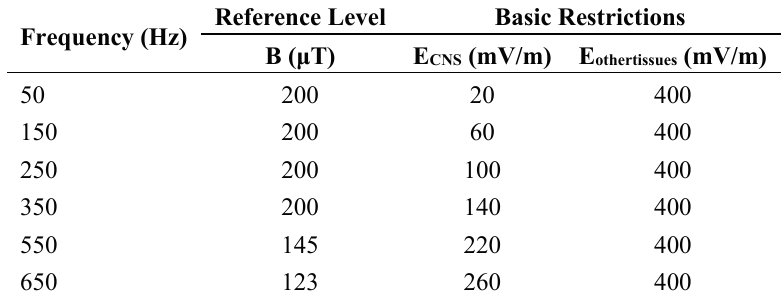
Table 2 as Reference Levels for magnetic flux density B and Basic Restrictions for the induced E 99th , at each frequency considered in this study. Table 2. Reference levels for magnetic flux density B rms (2nd column) and Basic Restrictions for induced Electric field E 99th strength over the central nervous system CNS (brain and spinal cord) (3rd column) and over all the other tissues (4th column), as a function of the frequency (1st column), according to the ICNIRP Guidelines [4]. All values are rms. Frequency